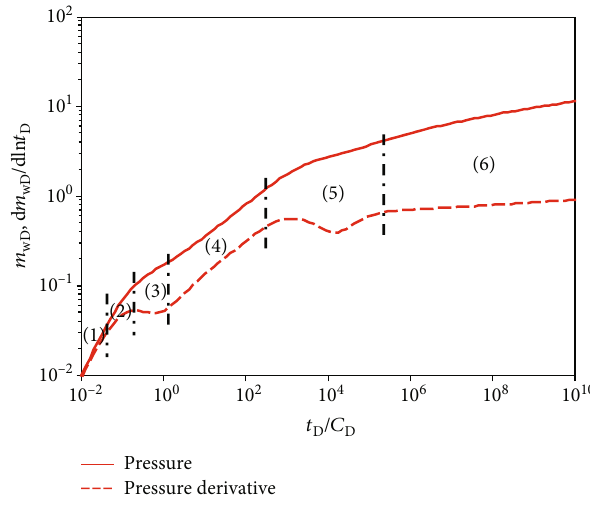
Figure 3: The transient responses with the log-log plot. Table 2: Parameters used for model